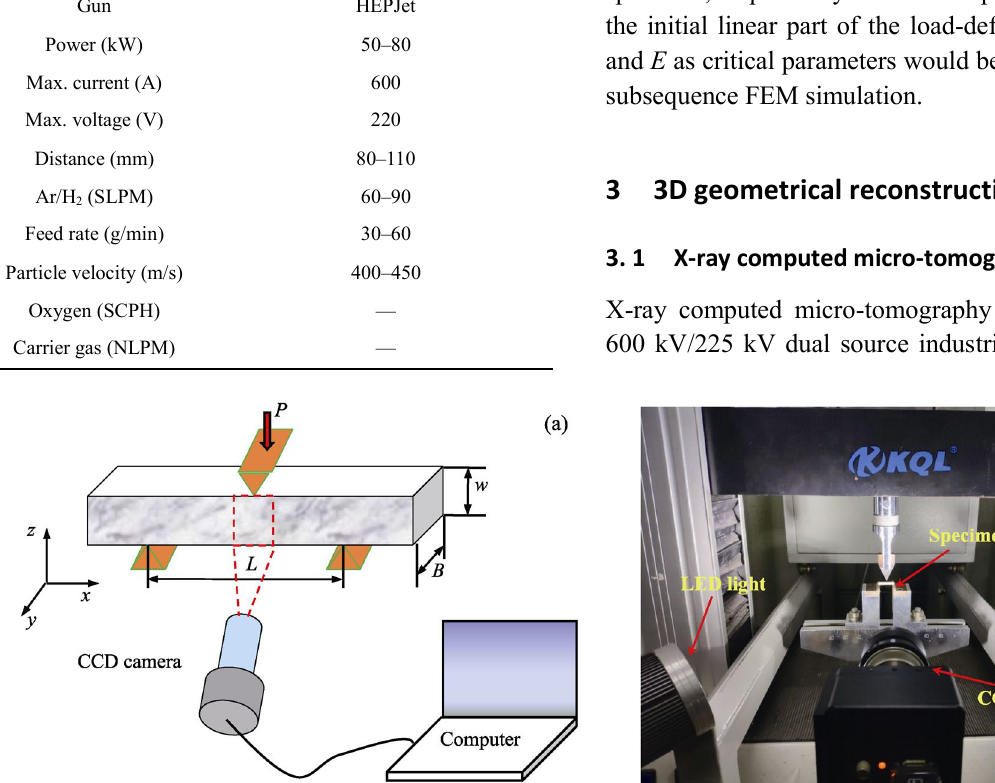
Fig. 1 (a) Schematic of three-point bending test with the aid of DIC and (b) the experimental